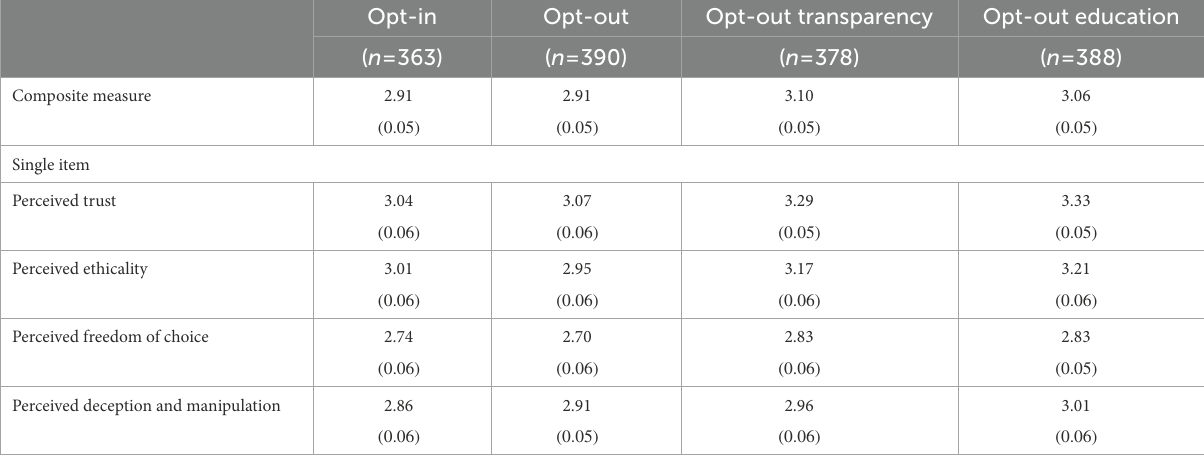
TABLE 5 Condition means and standard errors of acceptability